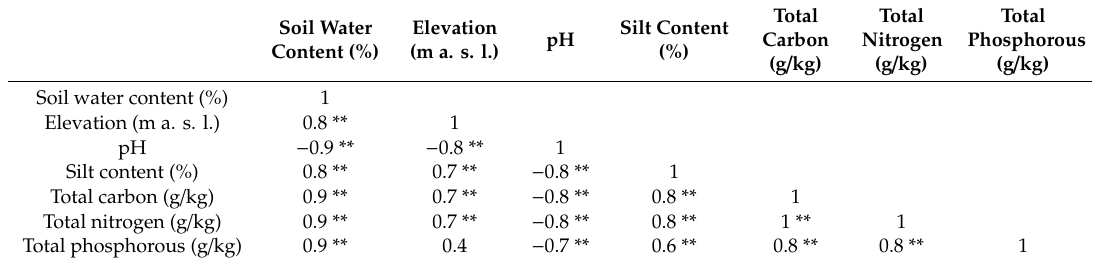
Table 6. Step-wise multiple linear regressions of soil water content from different depths (0 – 10 cm, 10 – 20 cm, 20 – 30 cm, 30 – 40 cm). N = 22, including sites in frozen ground areas.